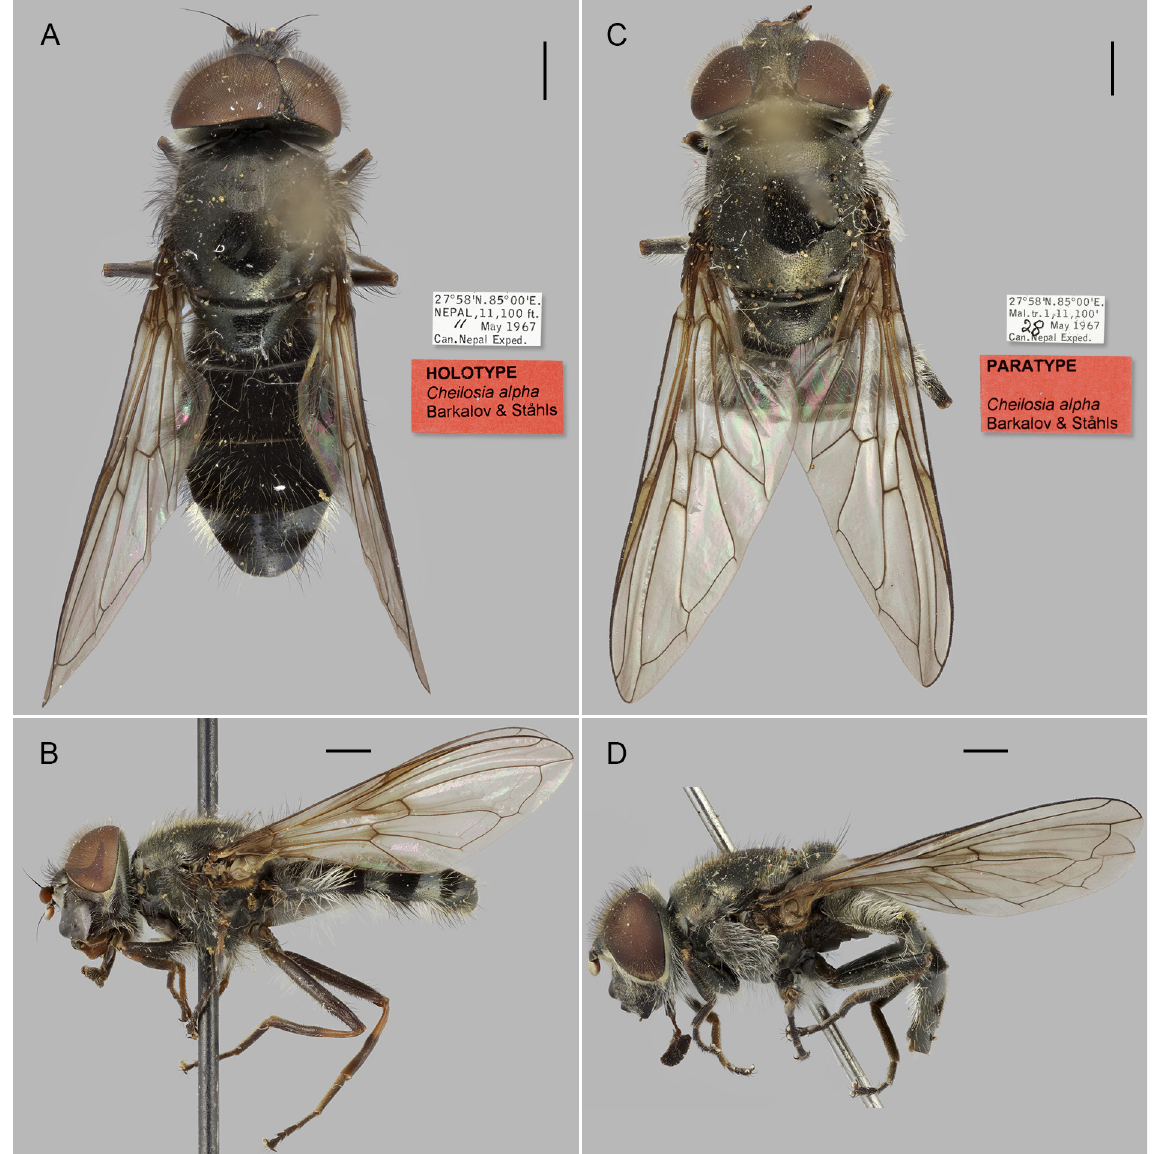
Fig. 6. Cheilosia ( Montanocheila ) alpha sp. nov. A–B . Holotype, ♂ (CNC); dorsal and lateral views. C–D . Paratype, ♀ (CNC); dorsal and lateral views. Photo: Pekka Malinen, FMNH Luomus. Scale bars = 1